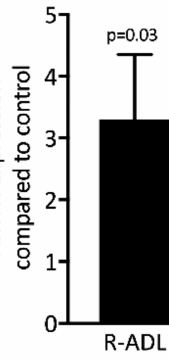
Figure 9. Root-derived ADL (R-ADL) and crown-derived ADL (C-ADL) induce the expression of AMTN. RT-PCR of AMTN shows regulation by R-ADL vs. C-ADL, n = 3. Statistics based on one-way ANOVA Kruskal–Wallis test, comparing treated samples to the untreated